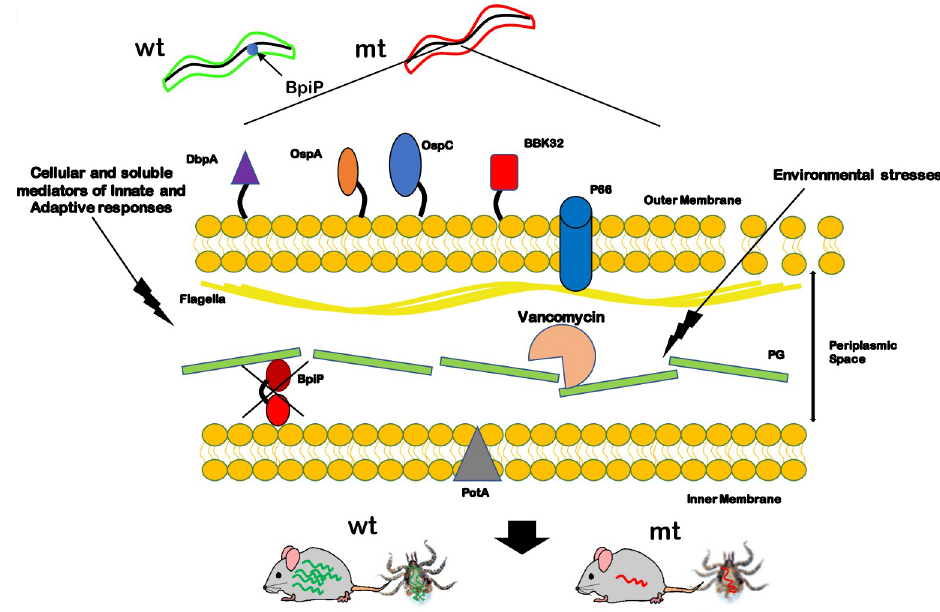
Fig 18. Graphical representation of role of BpiP. Structural, biochemical and genetic analysis reveal that BpiP interacts with the pentapeptide of borrelial PG stabilizing the cell wall integrity and most likely anchoring PG to the inner membrane. Absence of BpiP results in a mutant strain with a significant deficit in colonization of the mammalian host and the phenotypic analysis of bpiP mutant indicated increased sensitivity to a variety of environmental stressors as well as to soluble and cellular effectors of host immune response. The effects of pathogen- specific and host-derived PG degrading enzymes on borrelial PG are unknown and the role of BpiP conferring resistance to Bb against these enzymes is bound to open novel strategies to limit the survival of Bb during various stages of the infectious cycle.